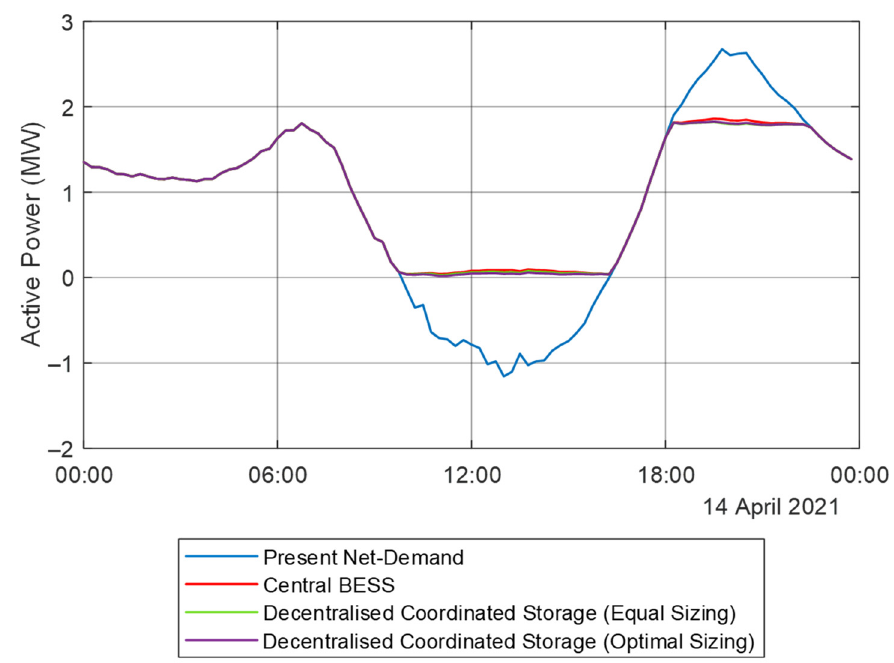
Figure 12. Net-demand profile at Xewkija DC with and without storage.